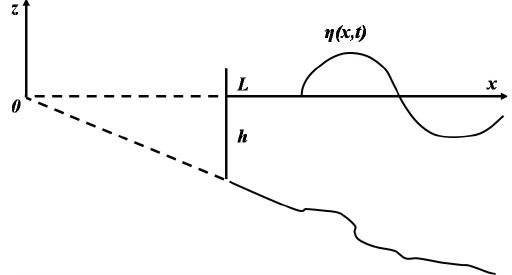
Fig. 1. Schematic presentation of the coastal